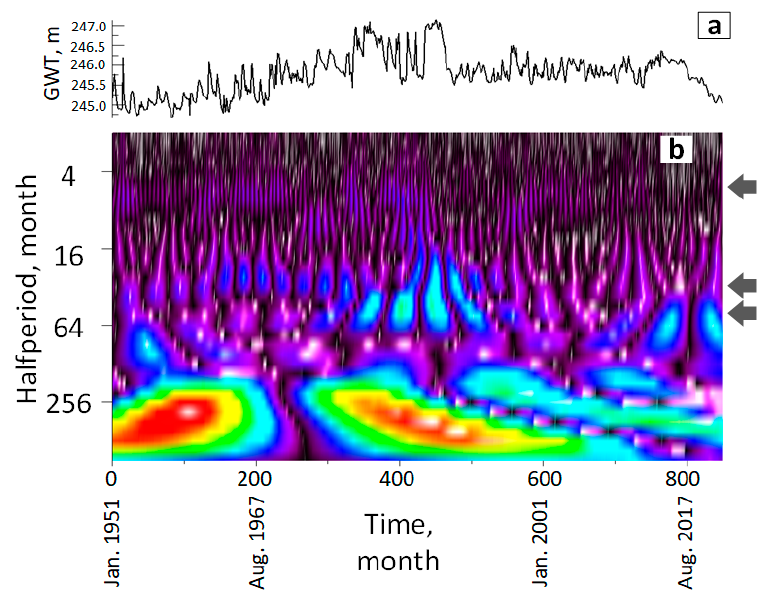
Figure 7. Top chart ( a ) is a chronological series of average monthly values of GWT (BSA, m) in the well # 5-3 (Khmilnyk, island part, 1.0–2.5 m) for 1951-2021. Bottom figure ( b ) is a two-dimensional picture of the coefficients of GWT wavelet-periodogram. See details in Figure 6. Cyclicity periods: top arrow—1 year, the middle arrow—5–6 years, lower arrow—8 years.